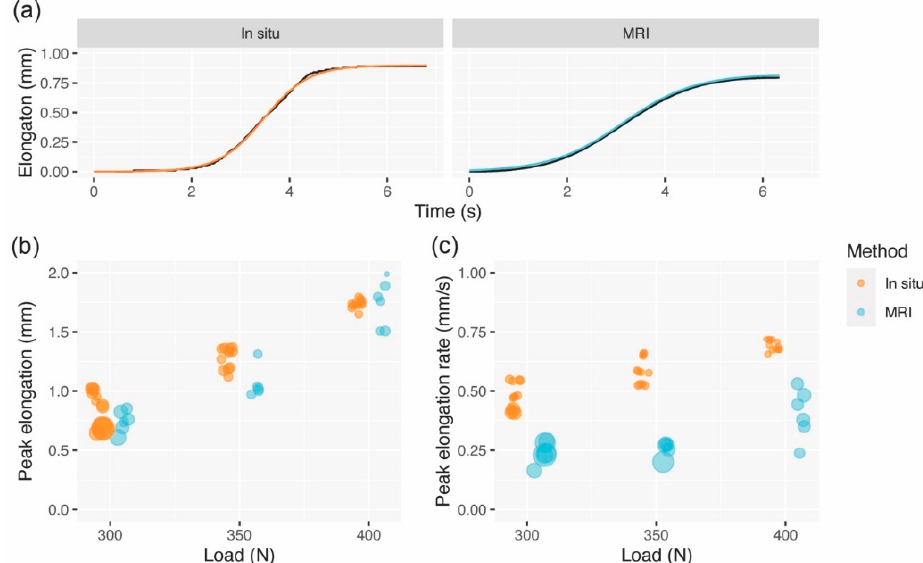
Figure 6. Results from logistic models. ( a ) Representative curves from a single rise cycle using 350 N; ( b ) Peak elongations from the in situ and MRI methods; and ( c ) Peak elongation rates from the in situ and MRI methods. Dot sizes ( b , c ) are in scale with inverse variance weighting.